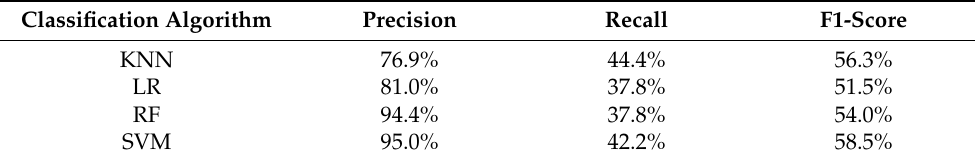
Figure 5. Precision–recall curves of KNN, LR, RF, and SVM on sample data after being filtered by multi-source semantic information. Table 3. Precision, recall, and F1-score of KNN, LR, RF, and SVM on sample data after being filtered by multi-source semantic